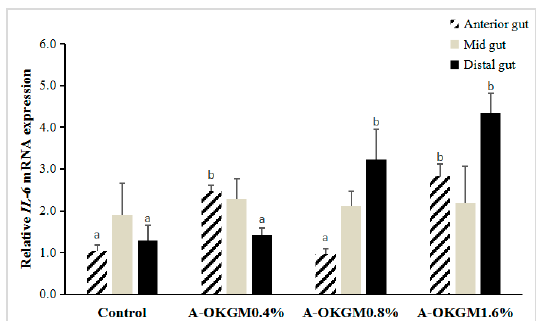
Figure 4. Effects of A-OKGM on IL-6 expression in the anterior, mid- and distal gut of Schizothorax prenanti . The observed values are expressed as the mean ± S.E. a,b Means with different superscripts are significantly ( p < 0.05) different from each other.